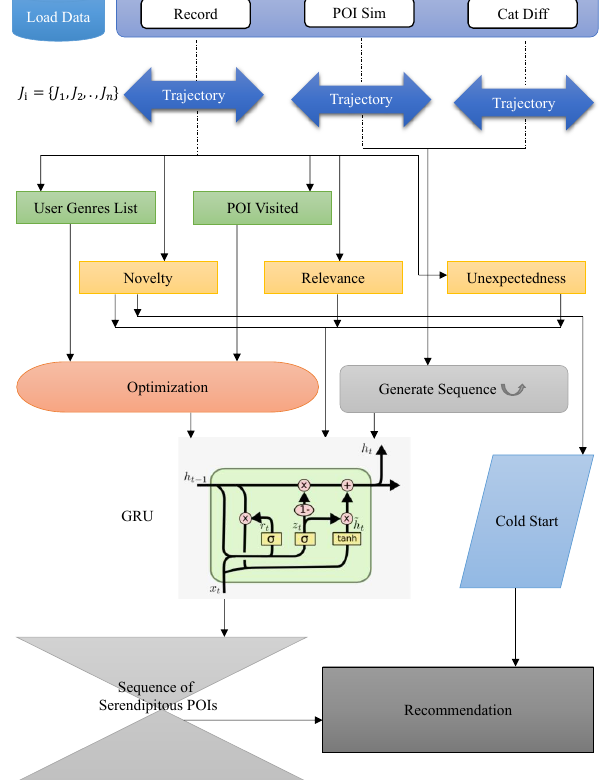
Figure 2. The architecture of